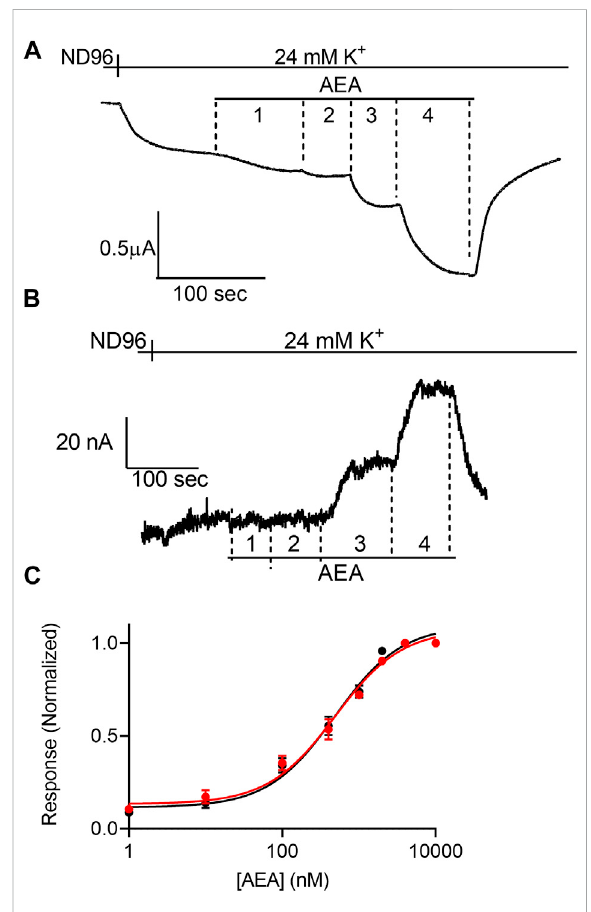
FIGURE 2 Voltage dependence of the potency of AEA. (A) and (B) . Measurement of the relationship between AEA concentration and GIRK currents at -80 mV and at +40 mV, respectively. Basal GIRK current is evolved following replacement of the solution to a high K+ solution. Then, 4 different AEA concentrations (1, 10, 400 and 10000 nM) were applied and the response for each concentration was measured. (C) . Dose response curves for severalAEAconcentrationsat − 80 mV(blacksymbolsandline; n = 31, 20, 20, 14, 25, 11, 8 and 41 for 1, 10, 100, 400, 1,000, 2000, 4,000, and 10000 nM, respectively) and at +40 mV (red symbols and line; n = 8, 10, 9, 8, 17, 11, 8 and 30 for 1, 10, 100, 400, 1,000, 2000, 4,000, and 10000 nM, respectively). The responses are normalized to the response evoked by 10000 nM AEA at each holding